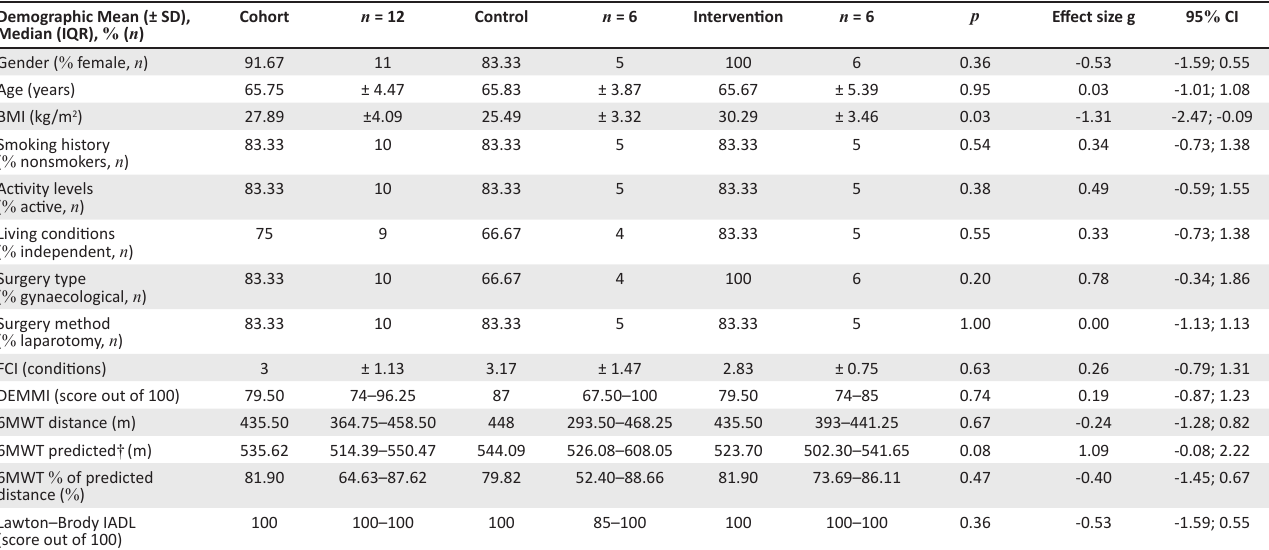
TABLE 1: Demographics and physical function of cohort at baseline ( n = 12). Demographic Mean (± SD), Cohort n = 12 Control n = 6 Median (IQR), % ( n )